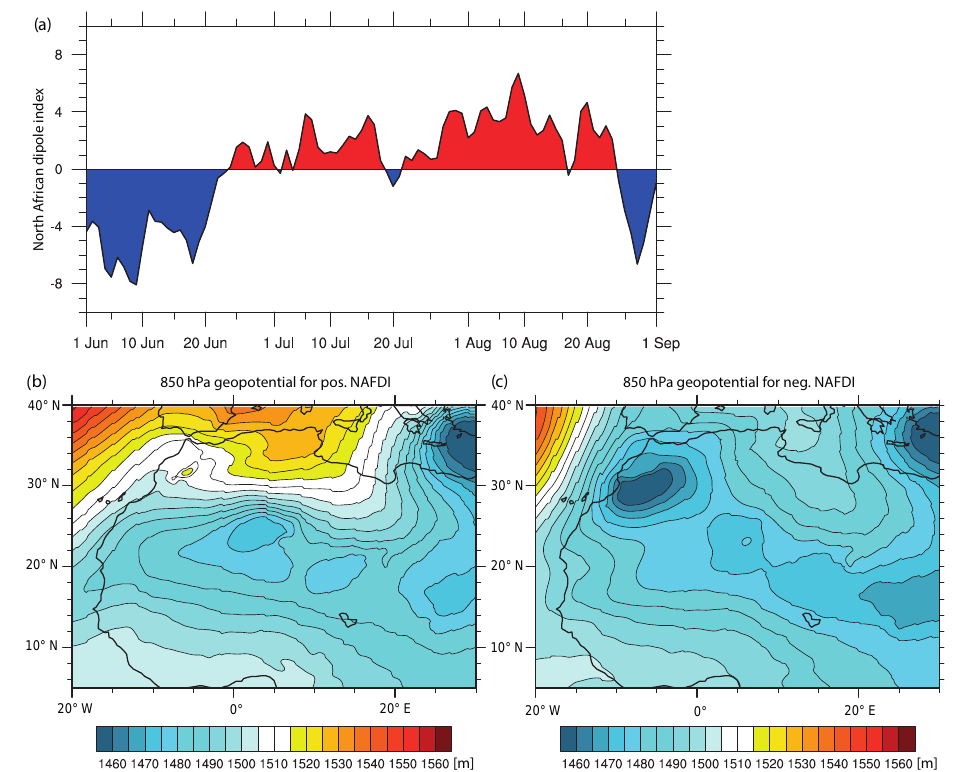
Figure 5. (a) North African dipole intensity index calculated following Eq. (1) reflecting the strength of the harmattan flow over North Africa. (b) Composite of 850hPa geopotential height (m) days within the 75th percentile range of the NAFDI index values, and (c) for days within the 25th percentile